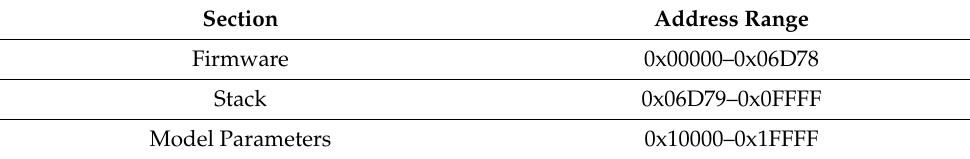
Table 6. IOb-SoC ECG-ID-BNet SRAM address